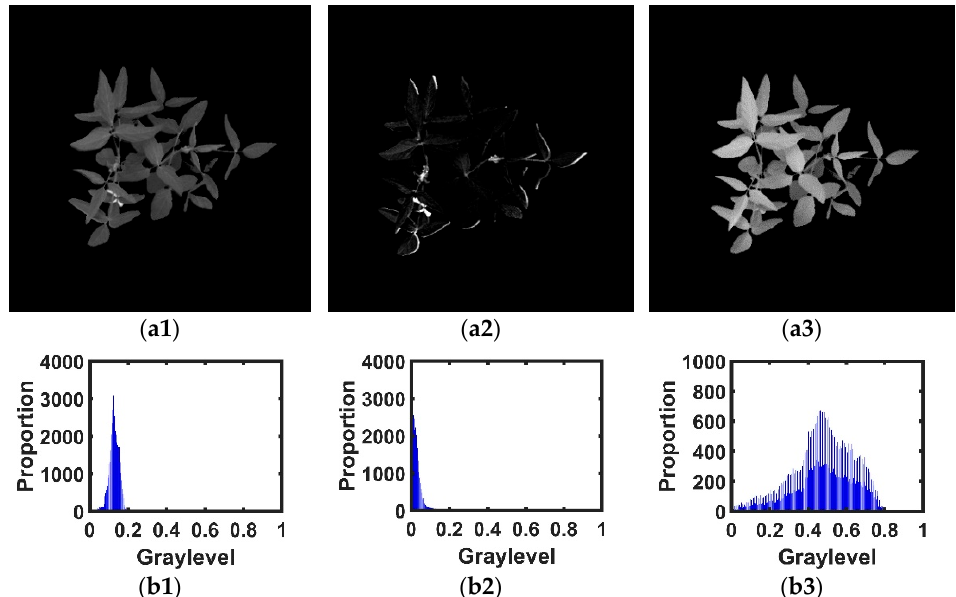
Figure 11. Extraction effect and corresponding histograms of the soybean canopy under normal treatment: ( a1 ) GRE target image, ( a2 ) RED target image, ( a3 ) REG target image, ( b1 ) GRE histogram, ( b2 ) RED histogram and ( b3 ) REG histogram.